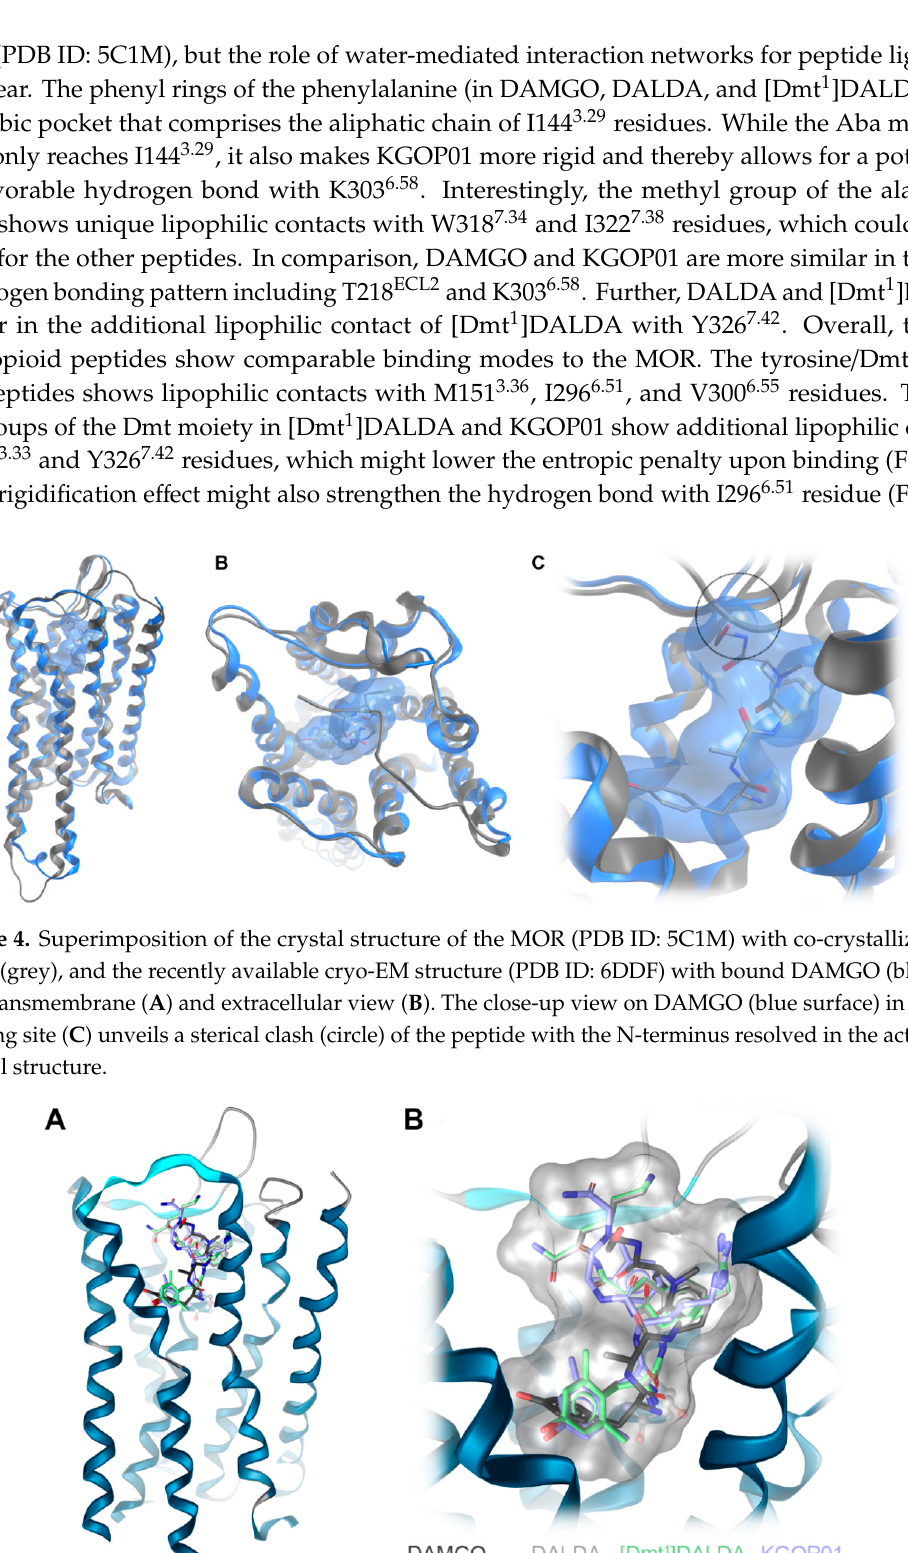
Figure 5. Investigated opioid peptides DAMGO, DALDA, [Dmt 1 ]DALDA, and KGOP01 show a comparable binding orientation in the inner core region of the human MOR model (based on PDB ID: 6DDF) ( A ). Aspartic acid D147 3.32 plays a major role in ligand binding through a charge interaction with the opioid peptides ( B